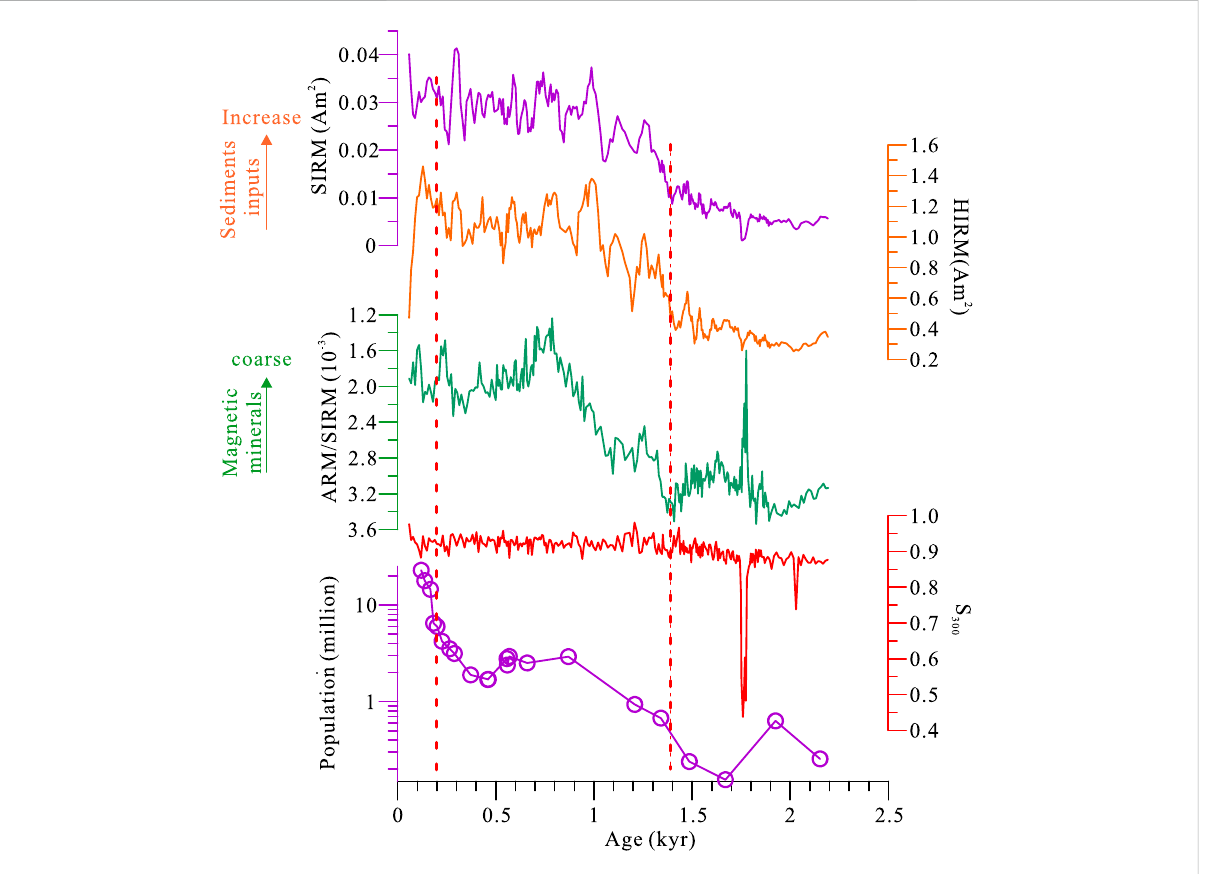
FIGURE 10 The relation of sediment inputs expressed by magnetic proxies with population growth in Guangdong Province (Zhu et al., 1988).